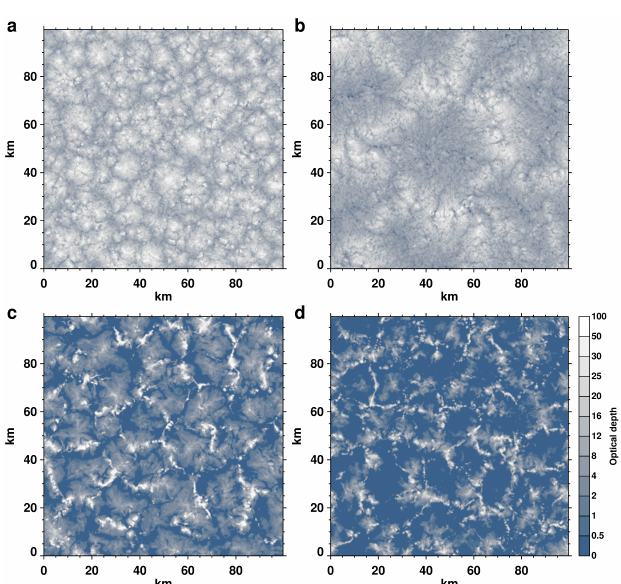
Fig. 2. Cloud optical depth in simulation S • (a, b) and S ◦ (c, d) , after 12h (a, c) and 36h (b, d)